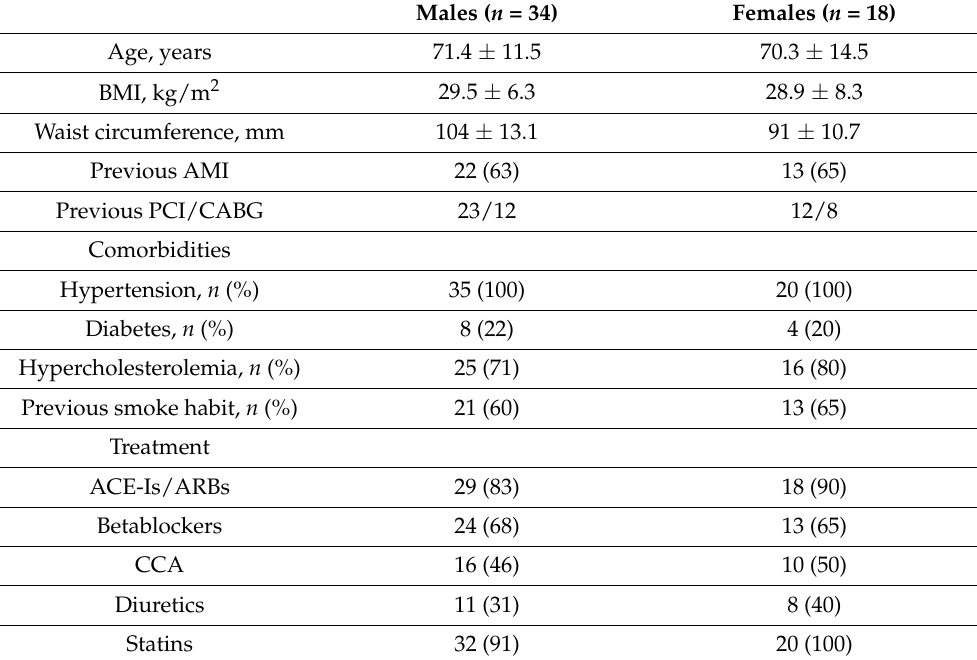
Table 1. Antropometric and clinical features of the population.